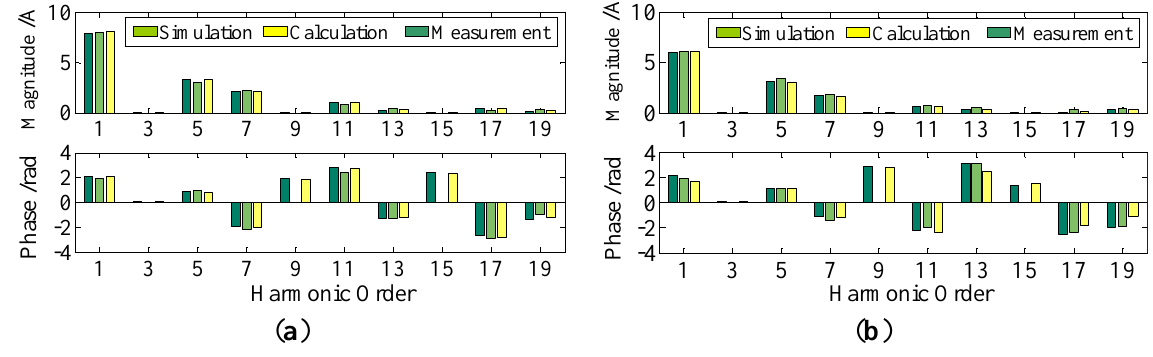
Figure 11. Comparison of the harmonic current amplitude and phase of the charging station: ( a ) case 1 and ( b ) case